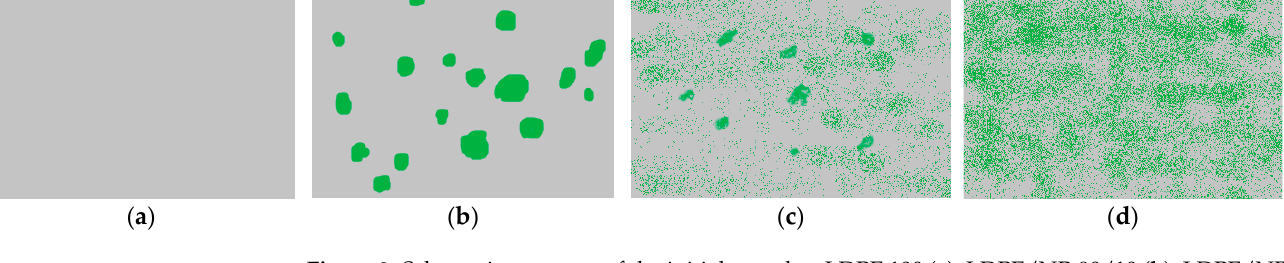
Figure 3. Schematic structure of the initial samples: LDPE 100 ( a ), LDPE/NR 90/10 ( b ), LDPE/NR 70/30 ( c ), LDPE/NR 50/50 ( d ), the LDPE matrix is shown in gray, the NR inclusion is green.